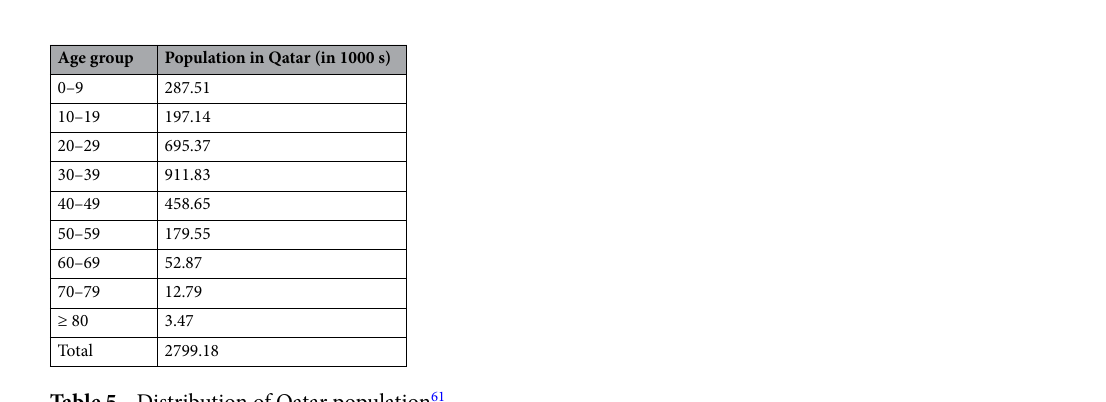
Table 5. Distribution of Qatar population 61